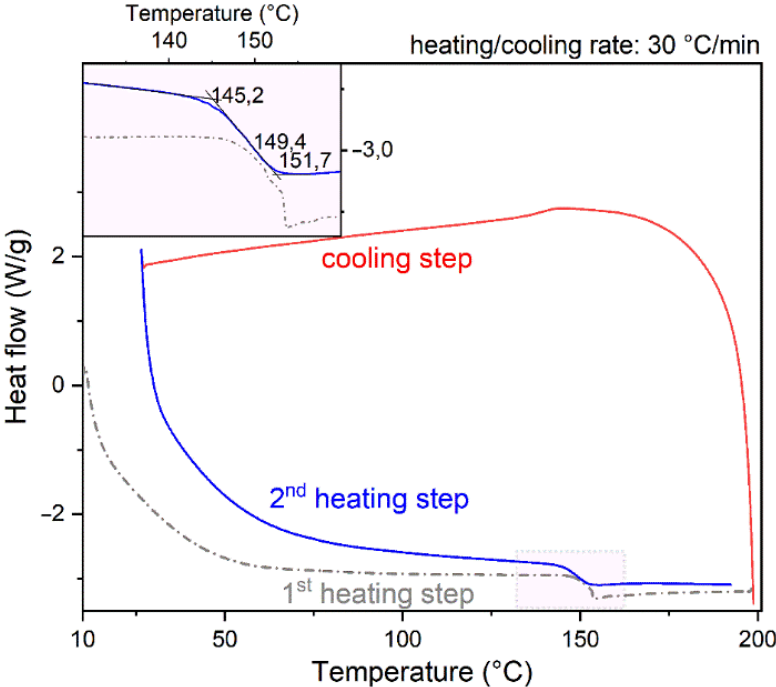
Figure 2. DSC profile of PC + CB-16 in heat-cool-heat cycle analysis. In the inset: 1st and 2nd heating runs are shown in the 130–160 °C temperature range and midpoint T g is determined in the last run.